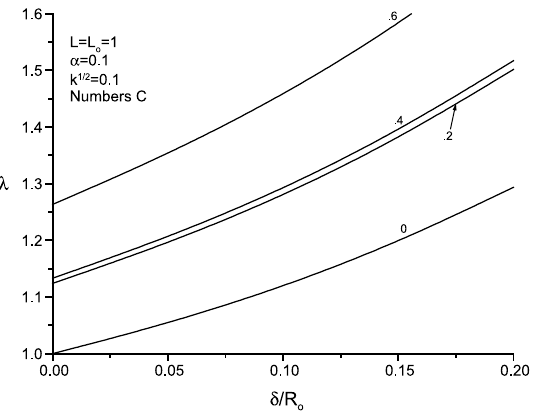
Fig. 4. Impedance, λ versus stenosis height, δ/ R o for different slip parameter, α